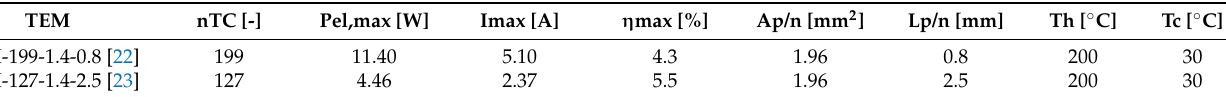
Table 1. Thermoelectric parameters of commercially available thermoelectric modules.